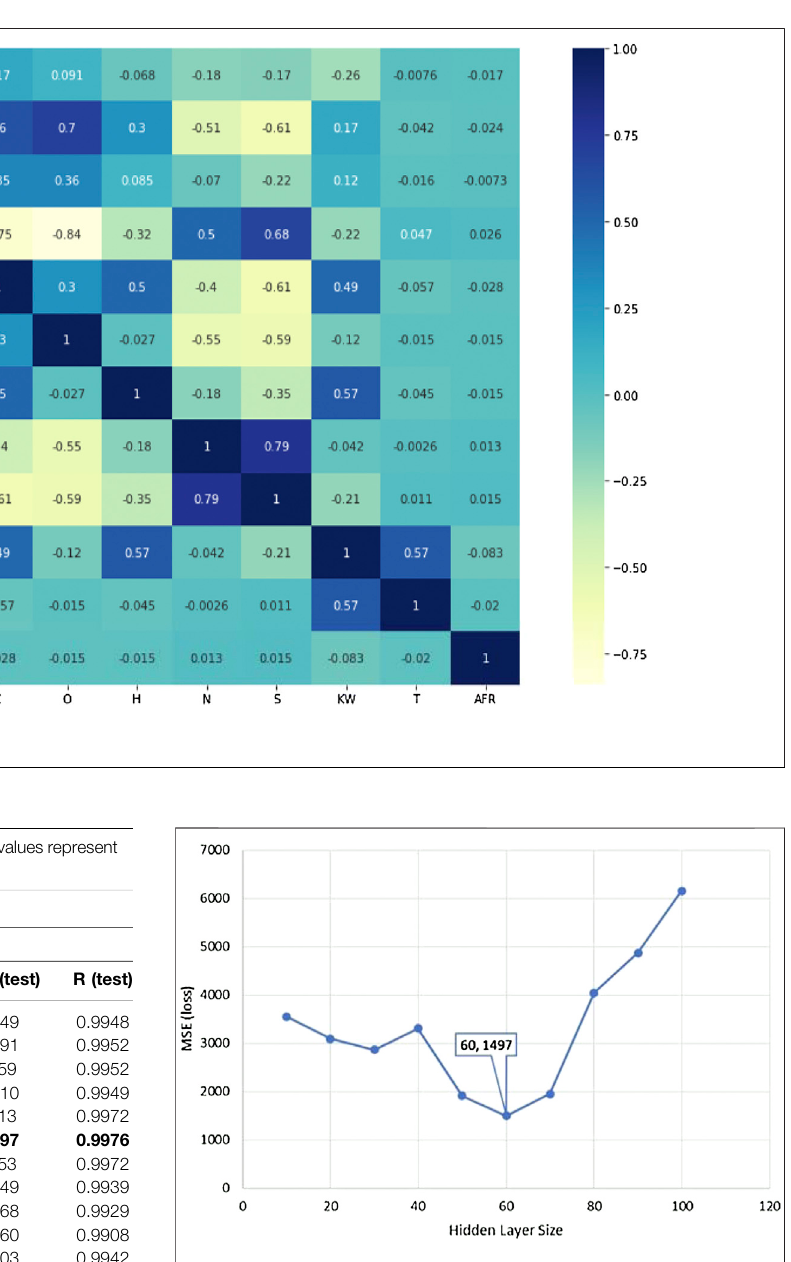
FIGURE 6 | Loss plot at various number of neurons at the hidden